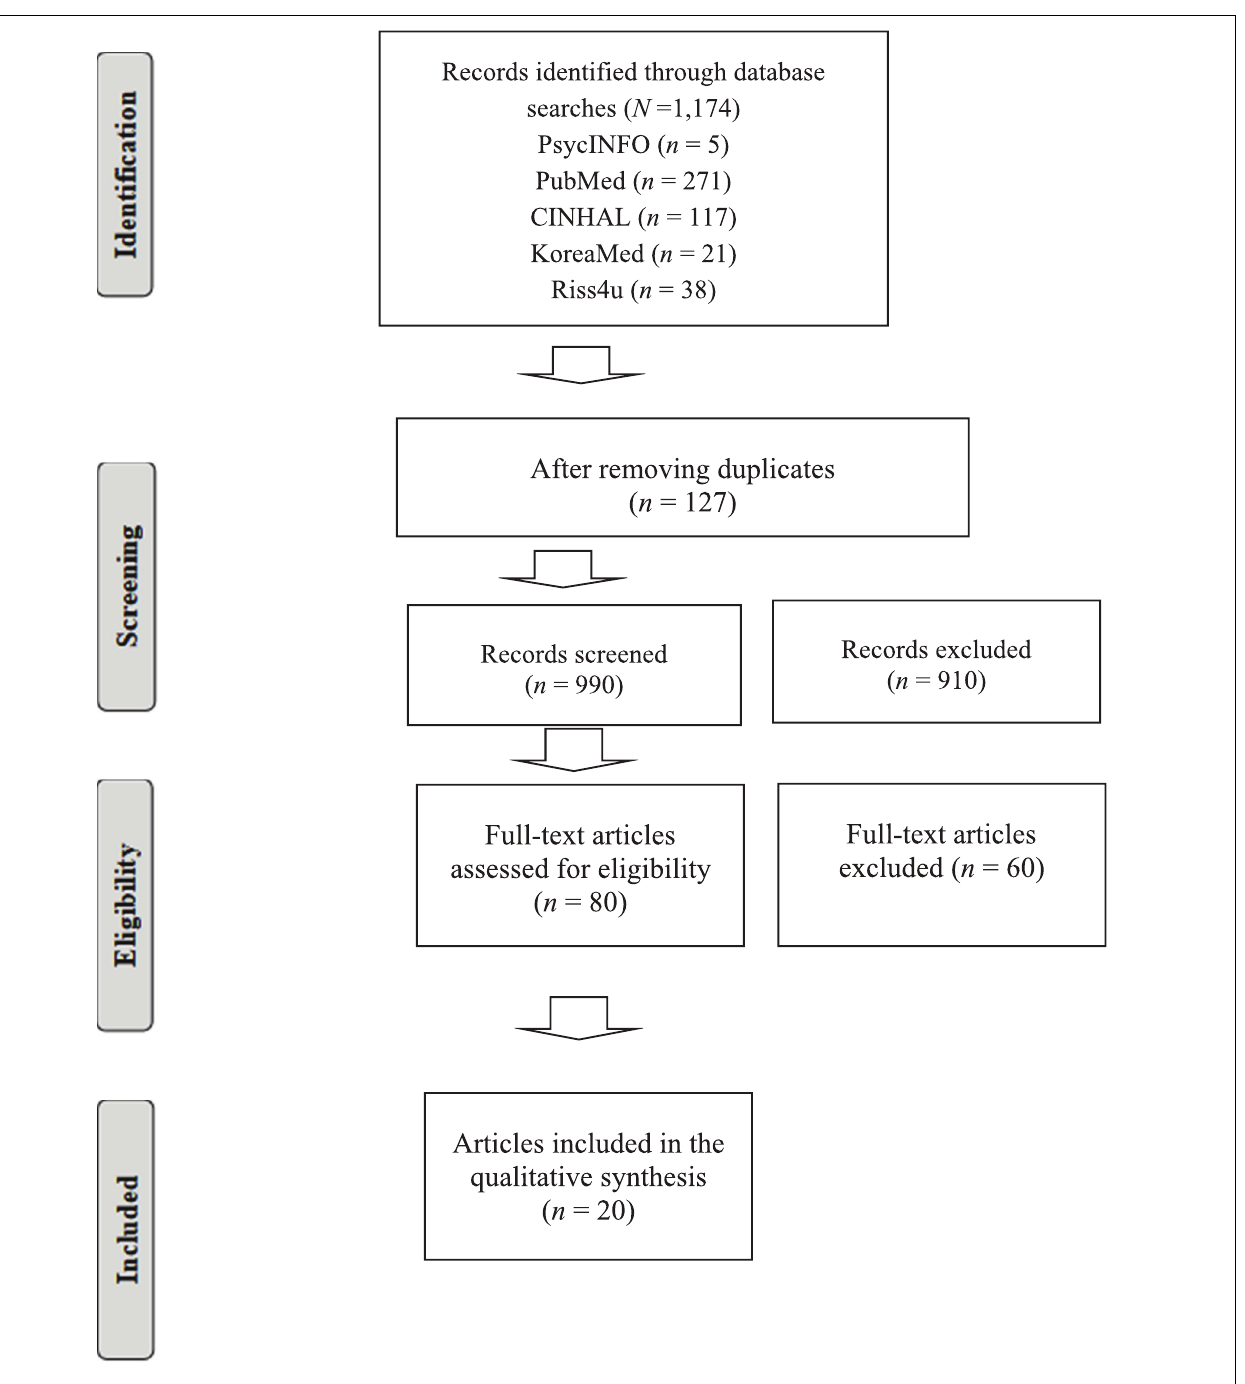
FIGURE 1 | Flow diagram of study selection for the scoping